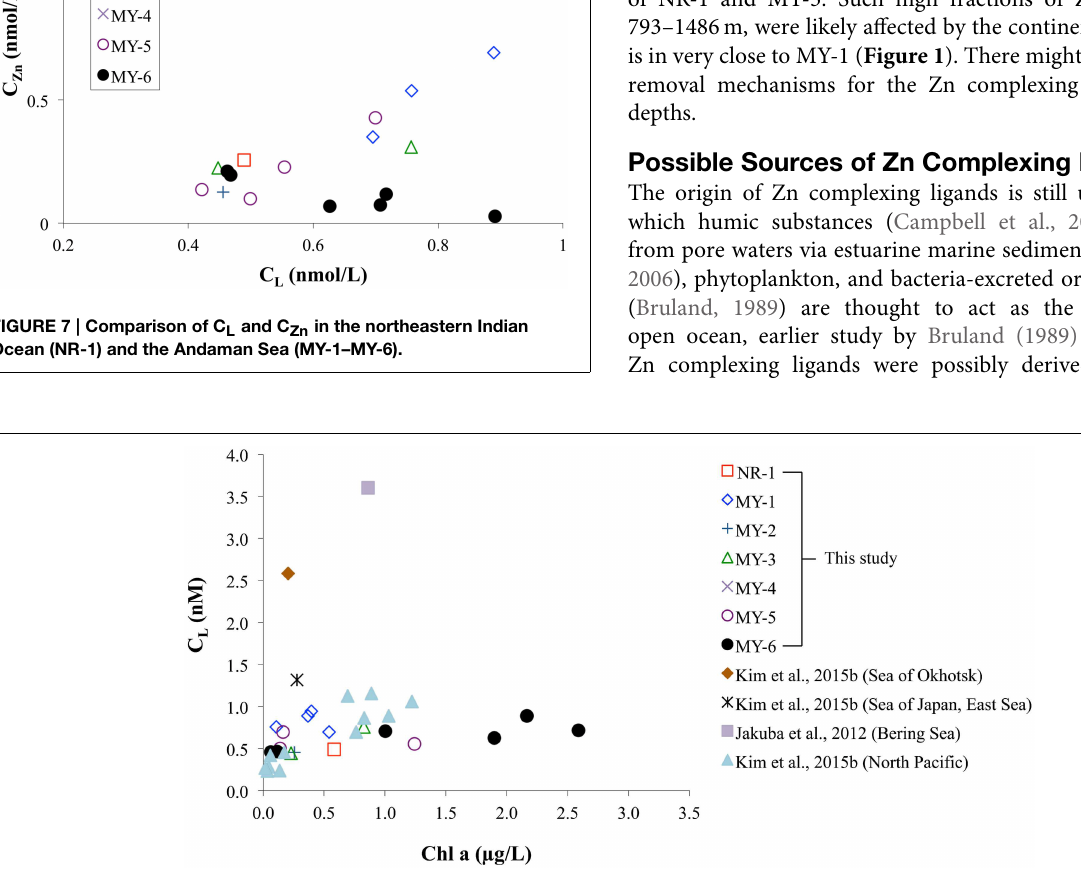
Frontiers in Marine Science |